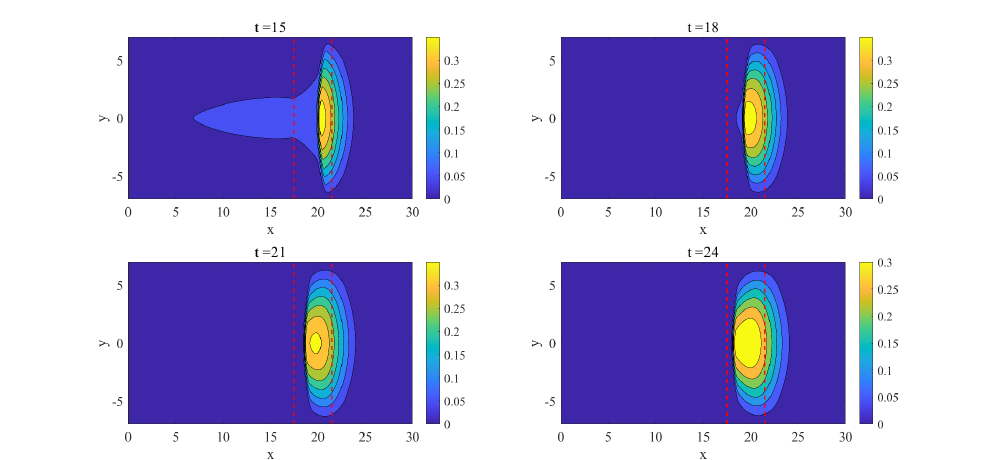
Figure 10. Thickness contours of the avalanche at t = 3,6,9,12,15,18,21,24 for the flow sliding down the inclined plane and merging continuously into a horizontal plane. The transition zone from the inclined plane to the horizontal plane lies between the two red dashed lines. The LF flux is used.